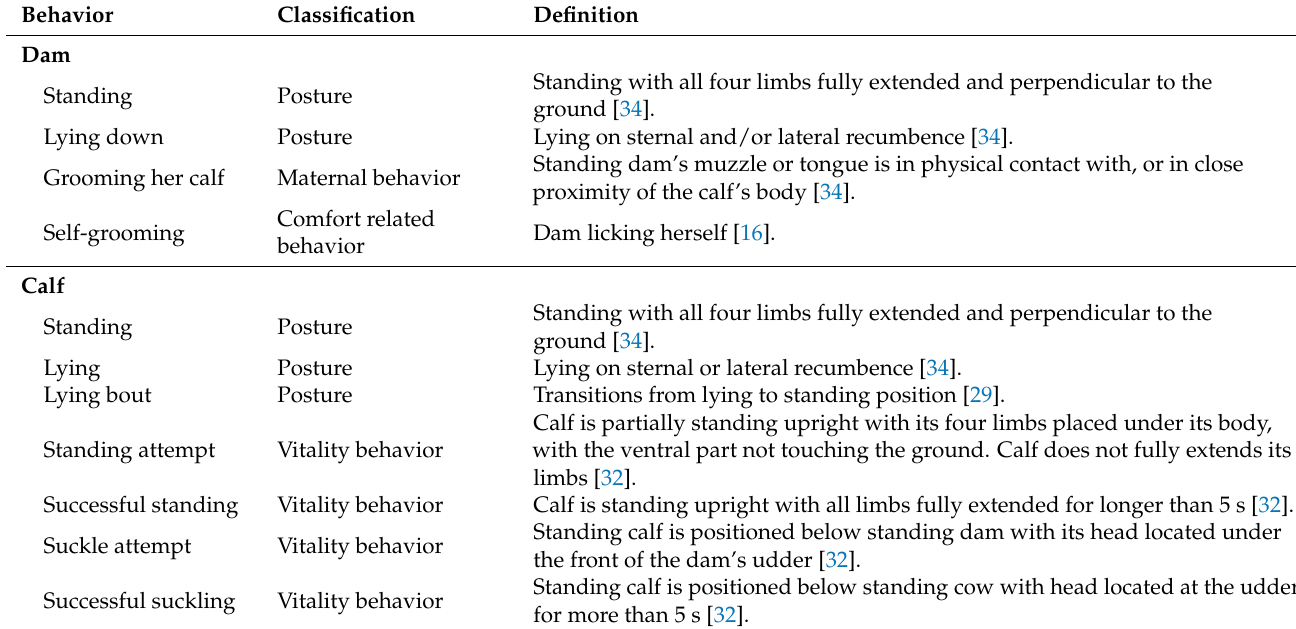
Table 1. Description of dam and calf recorded behaviors during the first 1.5 h after calving in all